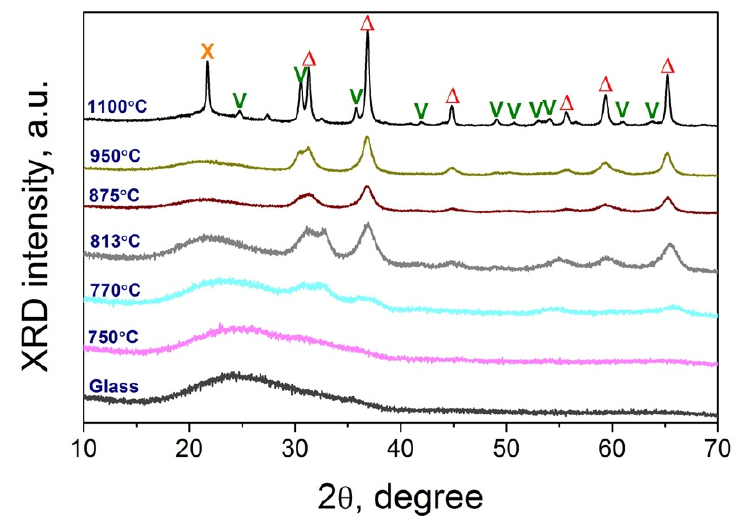
Figure 2. XRD patterns of the glass samples within the Matrix series after treatment at the indicated temperatures for 20 h compared to the XRD pattern of the parent glass. Symbols are indicated the following crystal phases: ∆ —#01-074-1136 (ZnAlO 4 ), V—#01-074-9434 (ZrTiO 4 ), X—#00-060-0061 following crystal phases: Δ —#01-074-1136 (ZnAlO 4 ), V—#01-074-9434 (ZrTiO 4 ), X—#00-060-0061 (Al 2 Mg 3 O 18 Si 6 ). The patterns are shifted for the convenience of (Al 2 Mg 3 O 18 Si 6 ). The patterns are shifted for the convenience of observation.